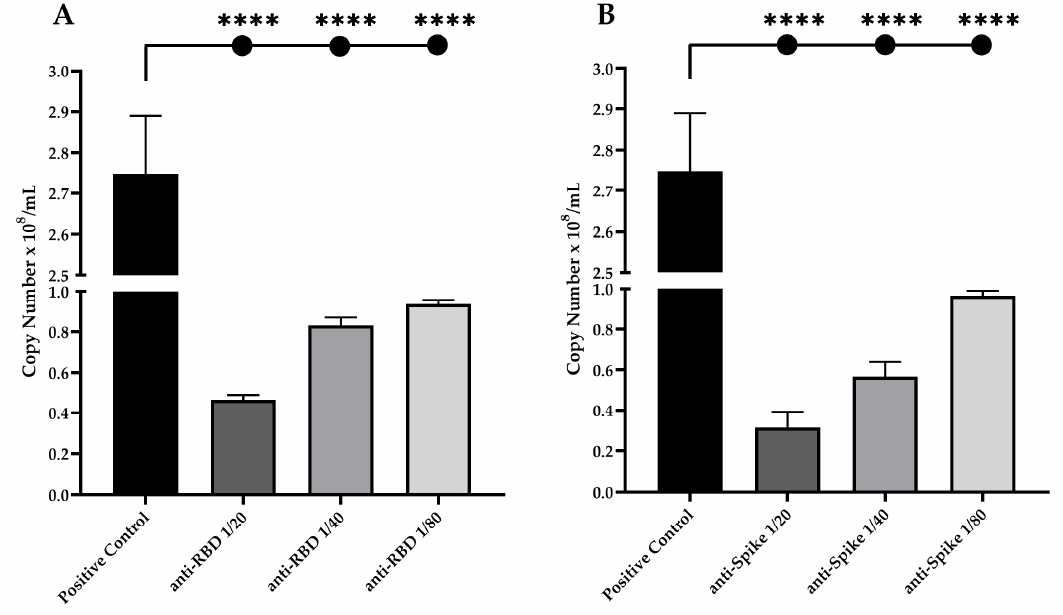
Figure 5. Serum neutralization expressed in copy number of SARS-CoV-2 B8 strain particles detected in a total amount of 1 µg of RNA. Twofold serially diluted (from 1:20 to 1:80) solutions of ( A ) anti-RBD or ( B ) anti-spike antibodies were incubated with 1000 PFU of SARS-CoV-2 B8 strain for one hour at 37 °C. Asterisks represent significant comparisons between positive control and serum treated cells (**** p < 0.0001).